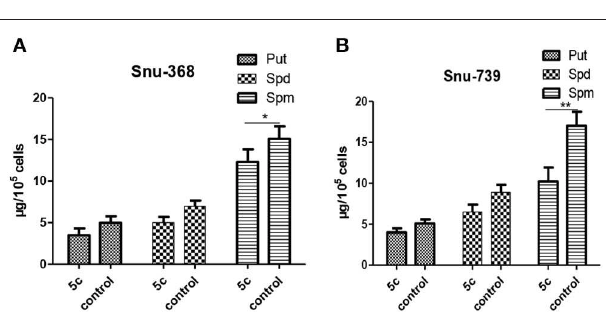
FIGURE 8 | Put, Spd, and Spm concentrations in Snu-368 (A) and Snu-739 cells (B) after 24h treatment with or without 5c was determined. * P < 0.05; ** P < 0.01.